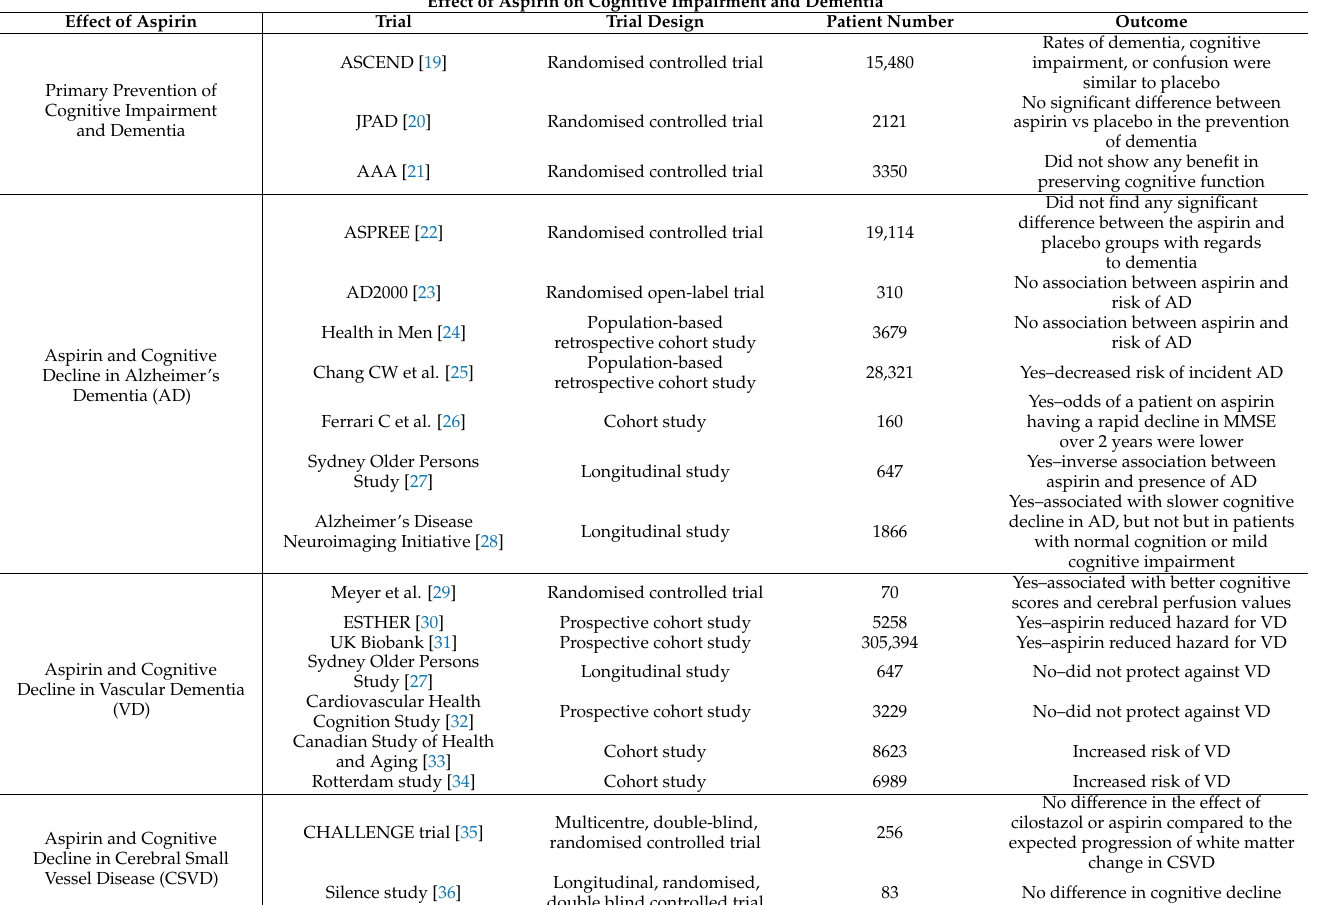
Table 1. Summary table of major trials discussed. AD: Alzheimer’s dementia; MMSE: Mini mental state exam; VD: Vascular dementia; CSVD: Cerebral small vessel disease; CHD: Coronary heart